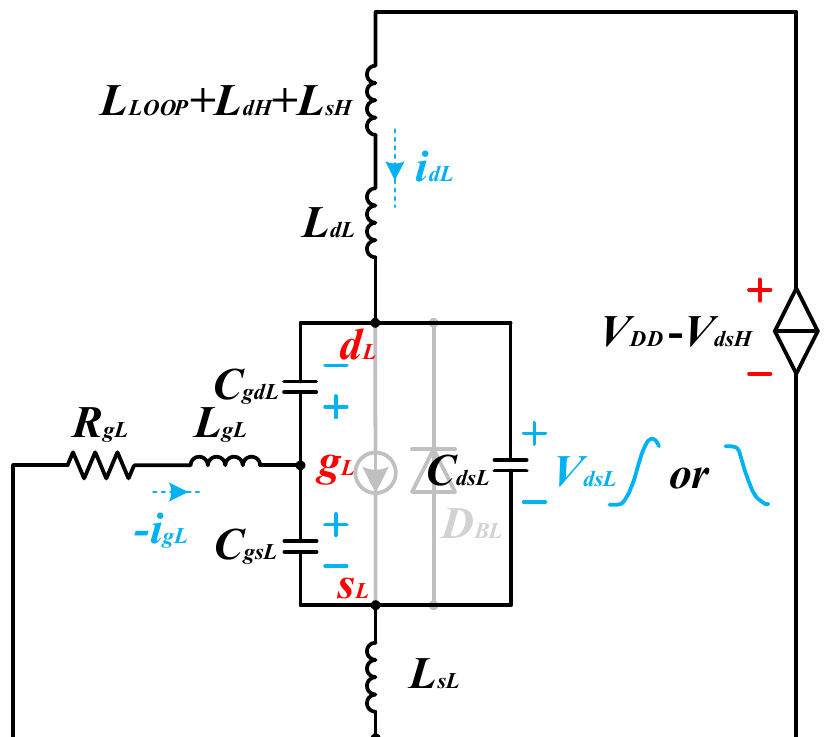
Figure 11. Equivalent circuits for V dsL analysis circuit.